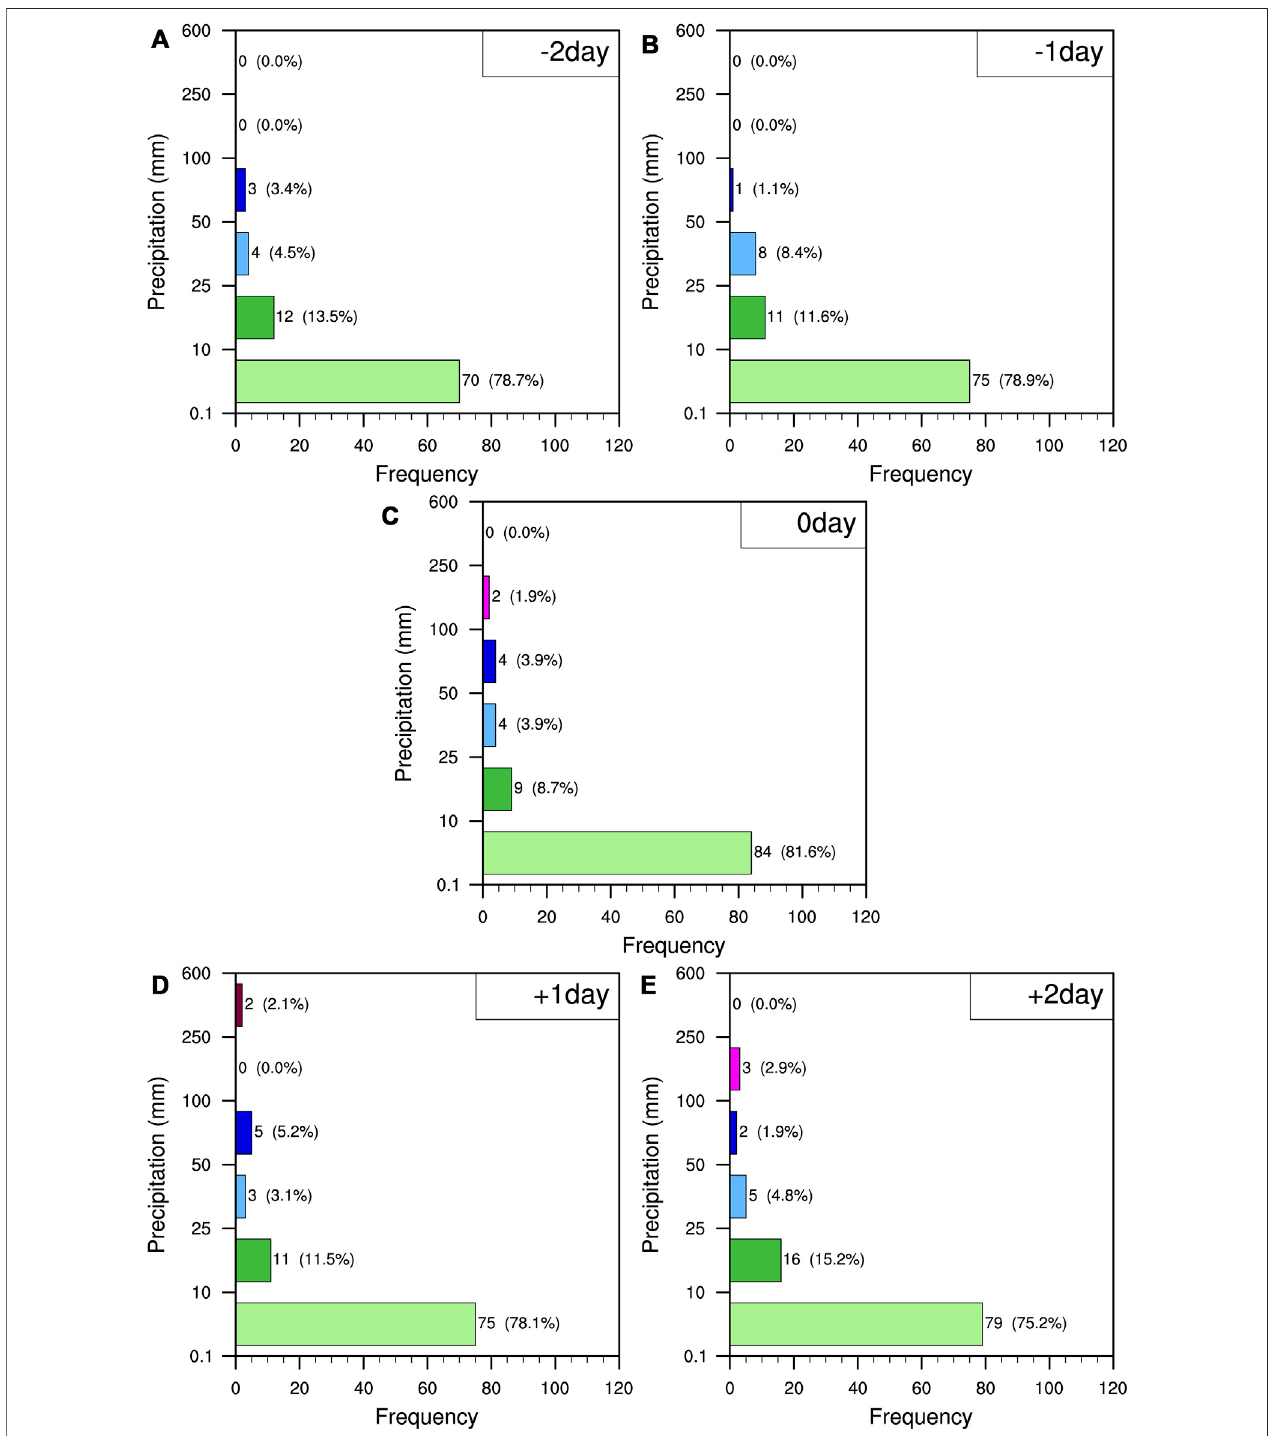
FIGURE 4 | Grade of daily precipitation (units: mm) for epicenter rainfall in the in fl uential period.